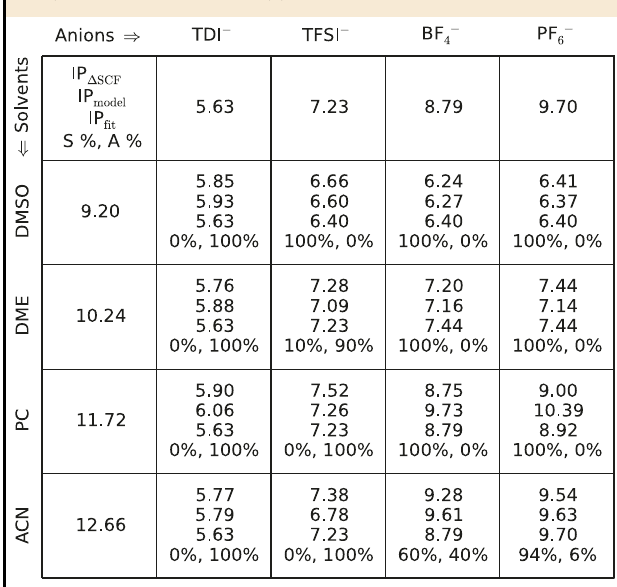
Table 2 Ionization potentials for 16 anion-solvent pairs computed with different